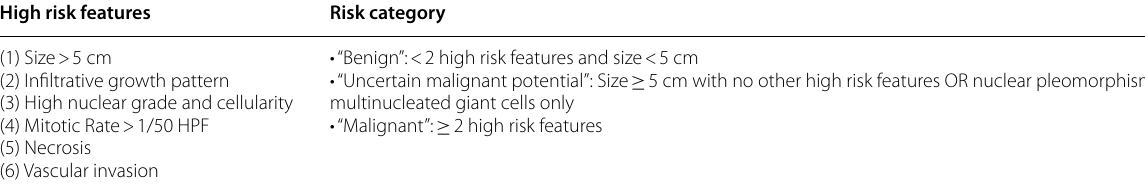
Table 1 Classification of malignant potential for non-gynecologic PEComas (adapted from [12]) High risk